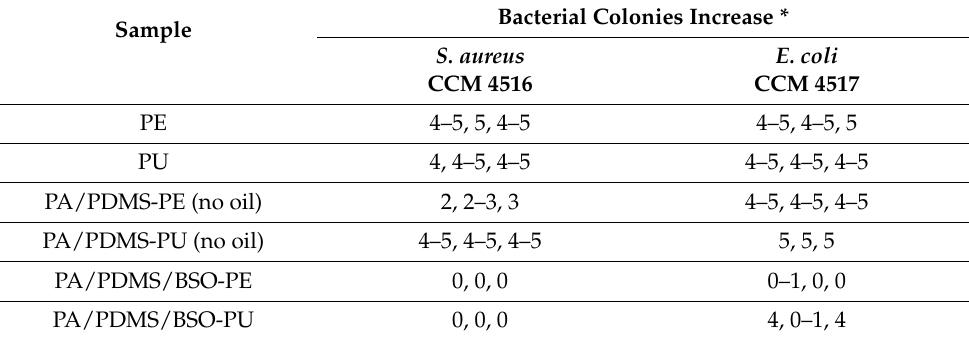
Table 4. Antimicrobial activity of prepared samples.